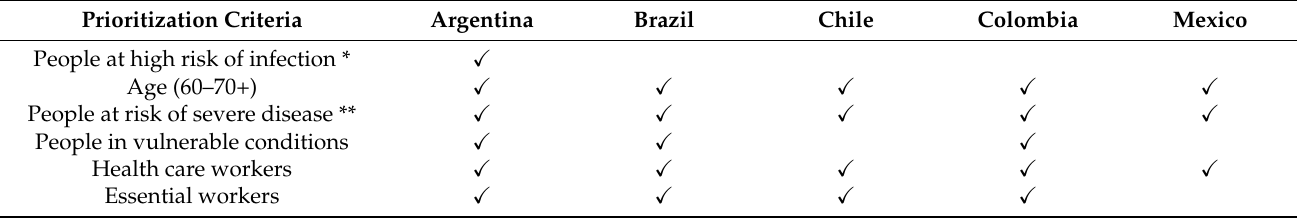
Table 2. Prioritization criteria according to national COVID-19 immunization plans in focus countries. Prioritization